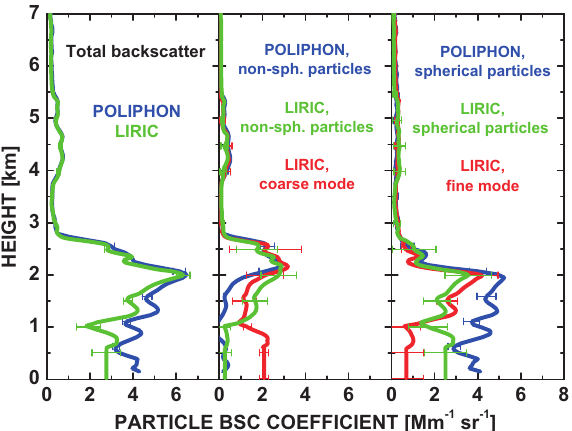
Fig. 10. Same as Fig. 4 except for a volcanic dust observation on Fig. 10. Same as Figure 4, except for a volcanic dust observation 19 April 2010. The POLIPHON curves are taken from Fig. 4 of on 19 April 2010. The POLIPHON curves are taken from Figure 4 Ansmann et al. (2012). Fig. 8. Range–corrected signal at 1064 nm on 19 April 2010, 1332– of Ansmann et al. (2012). 1743 UTC. The vertical resolution is 60 m, the temporal resolution is 30 s. The 500 nm AOT was 0.7 up to 6 km height in the afternoon of 19 April.